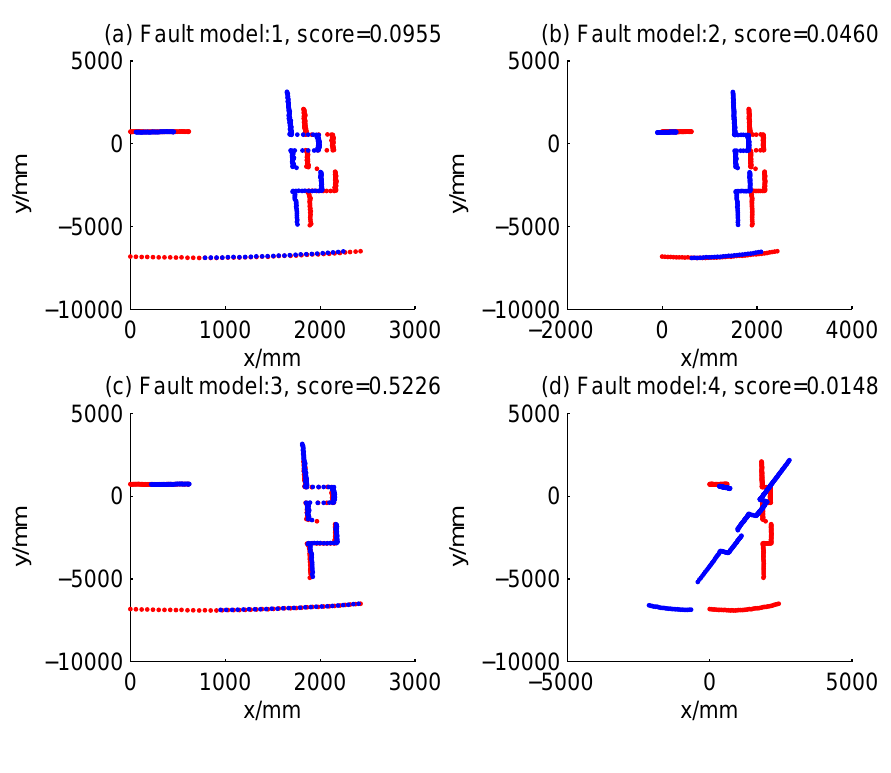
Figure 18. Case 3b: Right encoder stuck, fault model = 3 (time Step 13).